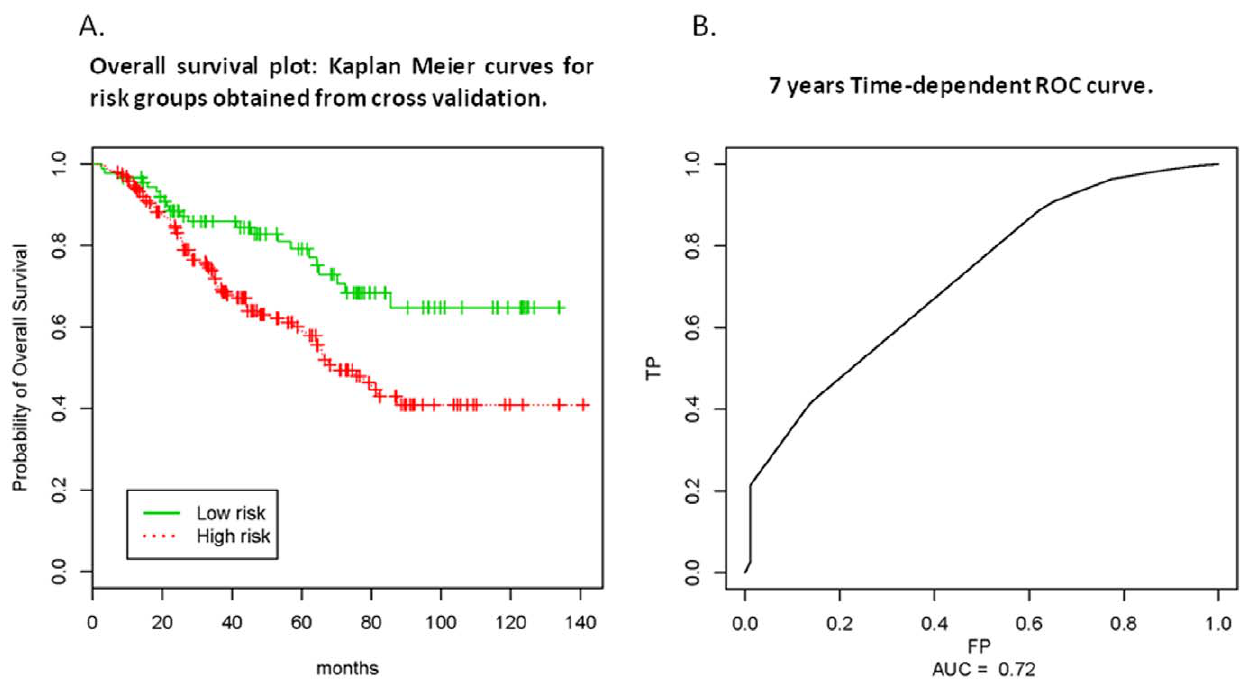
Figure 2. LOOCV Kaplan-Meier and Time-dependent ROC curves. A prognostic index for a patient with a specific genotyping profile were calculated as the weighted average (weighted as regression coefficient) of the five-marker genotypes. LOOCV Kaplan-Meier curve (Figure 2 A) identified 90 patients (22 deaths) in the low risk group (green line) and 194 (78 deaths) in the high risk group (red line). Time-dependent ROC curves showed that the AUCs at 5 and 7 year were 0.645 and 0.720, respectively (Figure 2B, 7 year survival ROC curve).